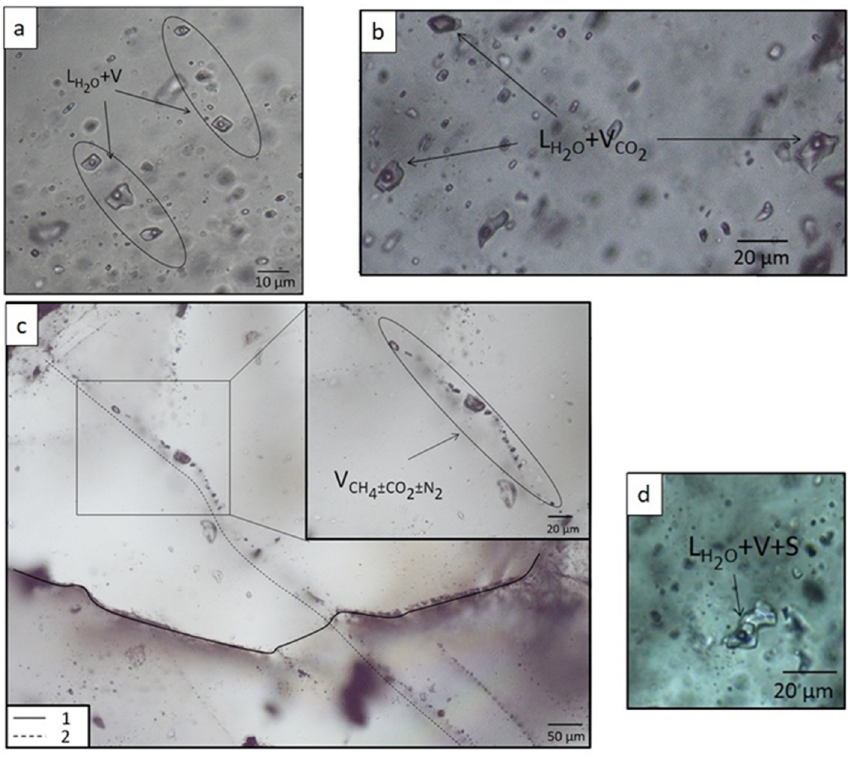
Figure 3. Types of fluid inclusions in quartz from the Blagodatnoye gold-ore deposit: a —type A, b —type B, c —type C (1—grain boundary, 2—secondary FI cutting the grain boundary), d —type D. Among examined 65 quartz plates, no quartz grains with growth zones were found.